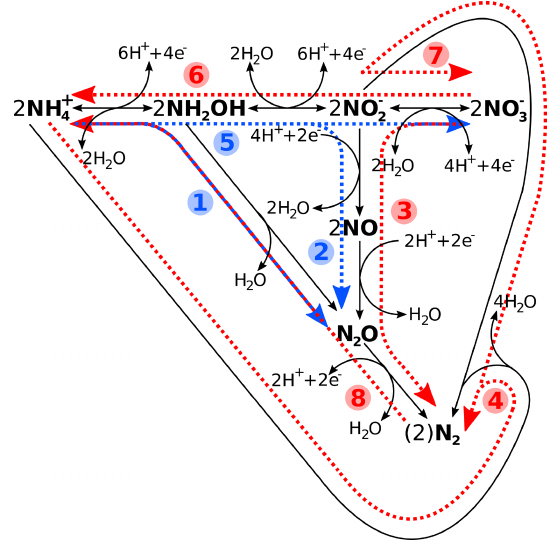
Figure 1. Schematic reaction diagram of major marine nitrogen cy- cling processes, with (1) hydroxylamine oxidation, (2) nitrifier den- itrification, (3) denitrification, (4) anammox, (5) nitrification, (6) ni- trate ammonification (DNRA), (7) anaerobic nitrite oxidation, and (8) nitrogen fixation. While processes 1–4 are considered nitrogen loss processes, 5–7 constitute neither a loss nor a gain, with (8) be- ing the latter. Blue denotes oxic and red suboxic and/or anoxic pro- cesses. Please note that, while the reactions have been chemically balanced for electro-neutrality, the exact amount of H + , e − , or wa- ter produced and/or consumed will depend on the actual organism or enzyme and reaction pathway. See Bourbonnais et al. (2017), Codispoti et al. (2005), and Zumft (1997), and references therein, for